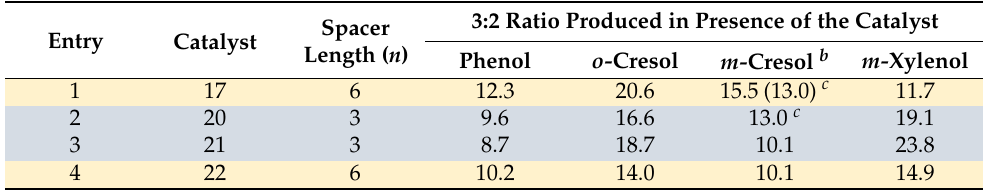
Table 2. Effect of cyclic and polymeric disulphides 17 and 20 – 22 on the selectivity of chlorination of phenols according to Scheme 1 a